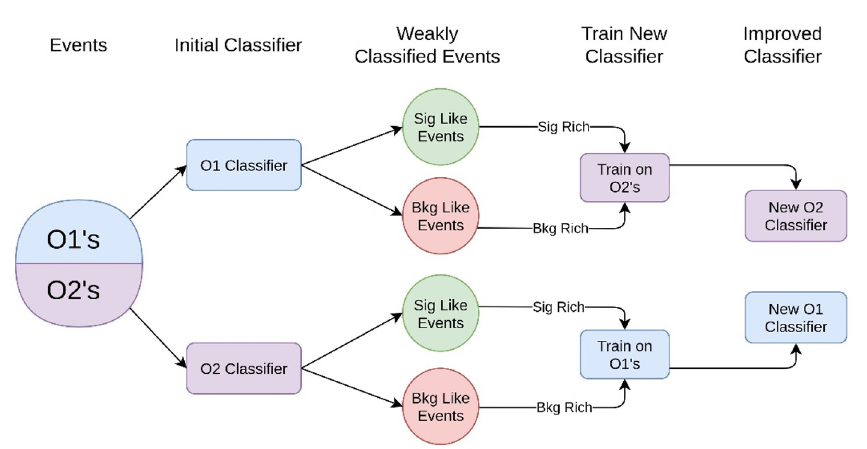
Figure 1 . An illustration of the Tag N’ Train technique. Here O1 and O2 represent Object-1 and Object-2, the two components of the data one wishes to train classifiers